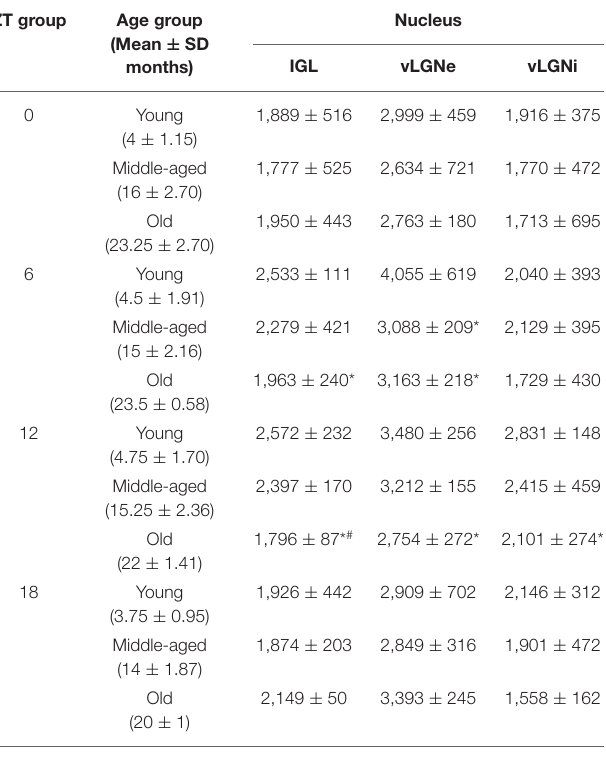
TABLE 1 | Mean CR + neuronal number estimated in the IGL, vLGNe, and vLGNi in each ZT and age groups. ZT